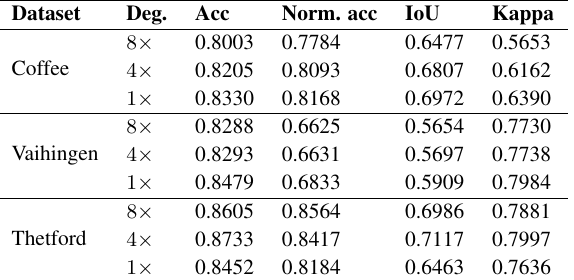
Table 1. Semantic segmentation performance of the end-to-end framework for different degradation